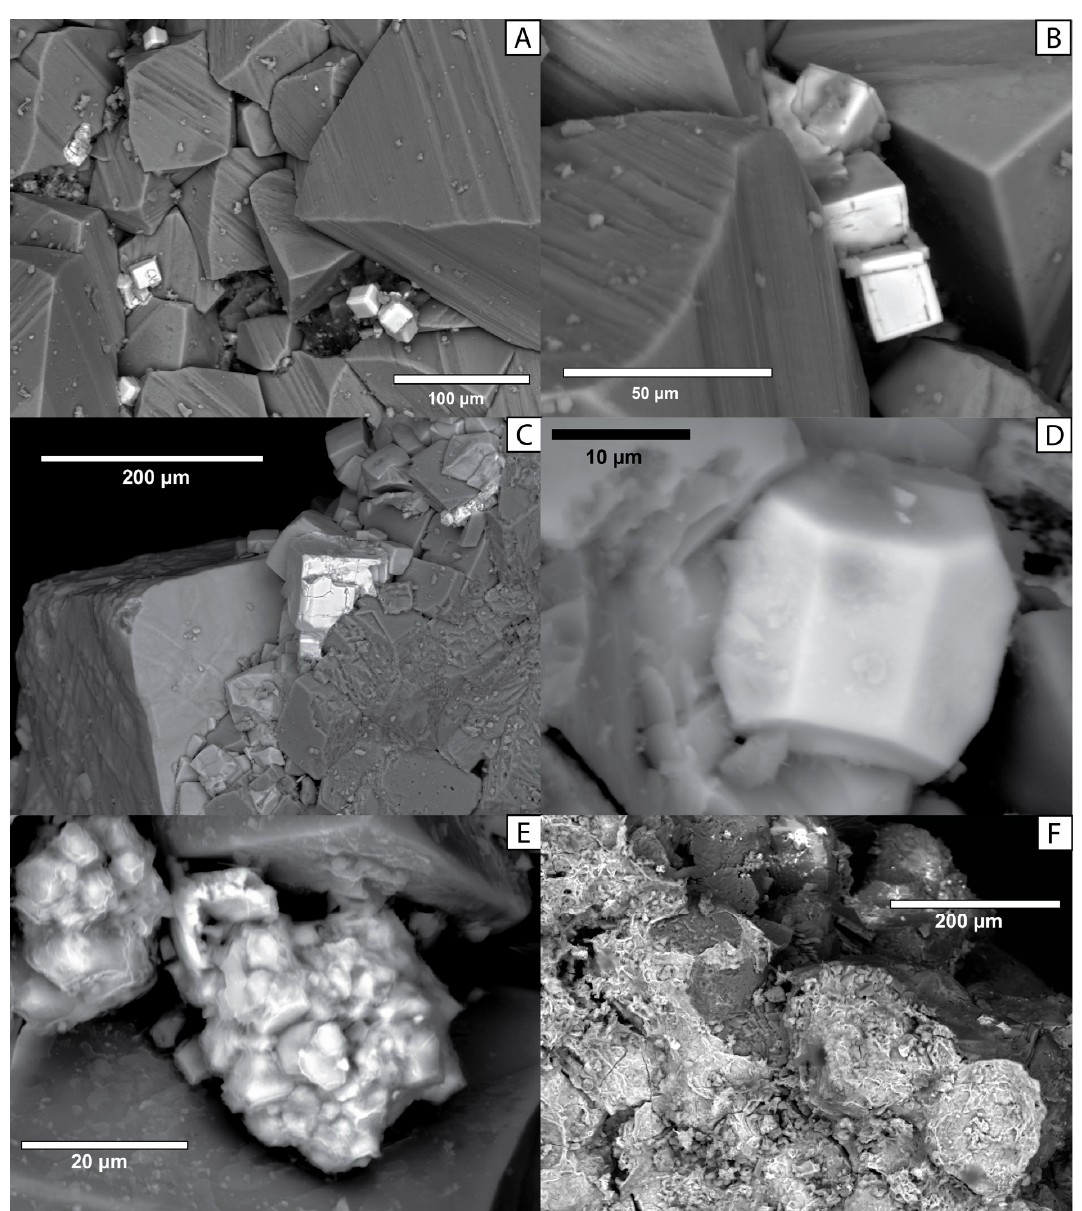
Figure 10. SEM-BSE images of selected Ni, Co, and As-bearing MVT minerals from three localities in the study area in northeastern Wisconsin. SEM-EDS data for ( A – E ) are shown in Table 1: (A,B) Locality 39 in Oconto County; (C–E) Locality 83 in Brown County; and ( F ) Locality 82 in Winnebago County. (A) Cubic bravoite (Ni, Co, Fe)S 2 on coarse dolomite (Sample 07-OCO-MTV-2; crystals 3-8). (B) Three crystals of cubic bravoite (2a–c) associated with nickelian pyrite (2d) (Sample 07-OCO-MTV-2; crystals 2a, 2b, 2c, and 2d). (C) Bright cubic crystal (center) with regions of both bravoite and vaesite associated with fluorite (medium gray, left) and dolomite (dark gray, lower right) (Sample AP-24; 510-515 ft; crystal 2). (D) Bravoite crystal (Ni, Co, Fe)S 2 showing both cubic and pyritohedron forms (Sample AP-24; 510-515 ft; crystal 4). (E) Arsenic-bearing nickelian pyrite in finely crystalline masses. Sample AP-24; 520-525 ft; crystal cluster A. (F) Amorphous pink coating of Co-Ni-As-Zn-bearing material (Figure 5) that is likely a sulfate or an arsenide, possibly erythrite (Sample 97-WIN-3). Table 1. Concentrations of elements in selected crystals of Ni-Co-Fe-As-sulfide minerals from Brown and Oconto Counties. Values are reported in weight % generated from the EDAX Software. Sample